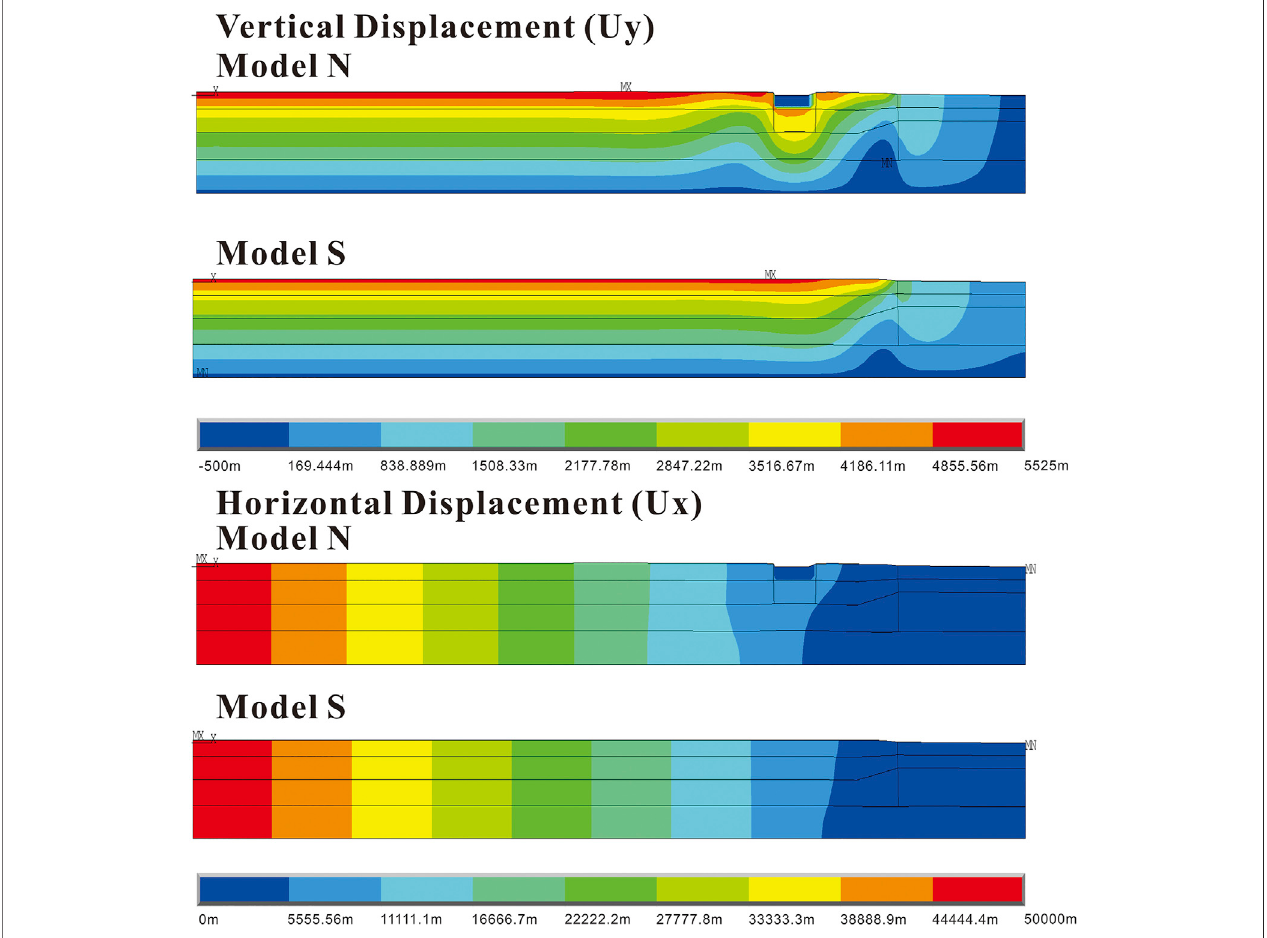
FIGURE7| Compared tothesimulation resultsofdisplacementsinModelSand ModelN.Theabovetwoaretheresultsofverticaldisplacement.Thenexttwoare the results of horizontal displacement. MX: Maximum displacement; MN: Minimum displacement; X: x direction.